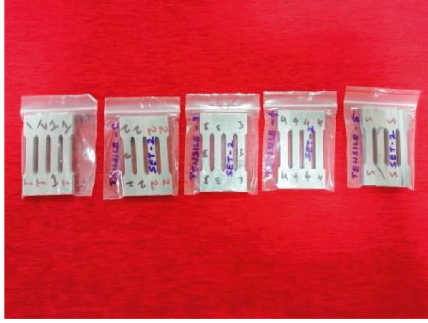
Figure 7: Creep test samples as per ASTM standard.